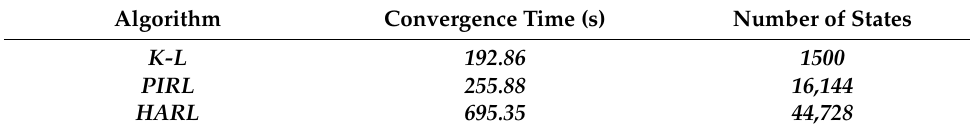
Table 7. Time of convergence and the number of states in a 40 × 40 raster